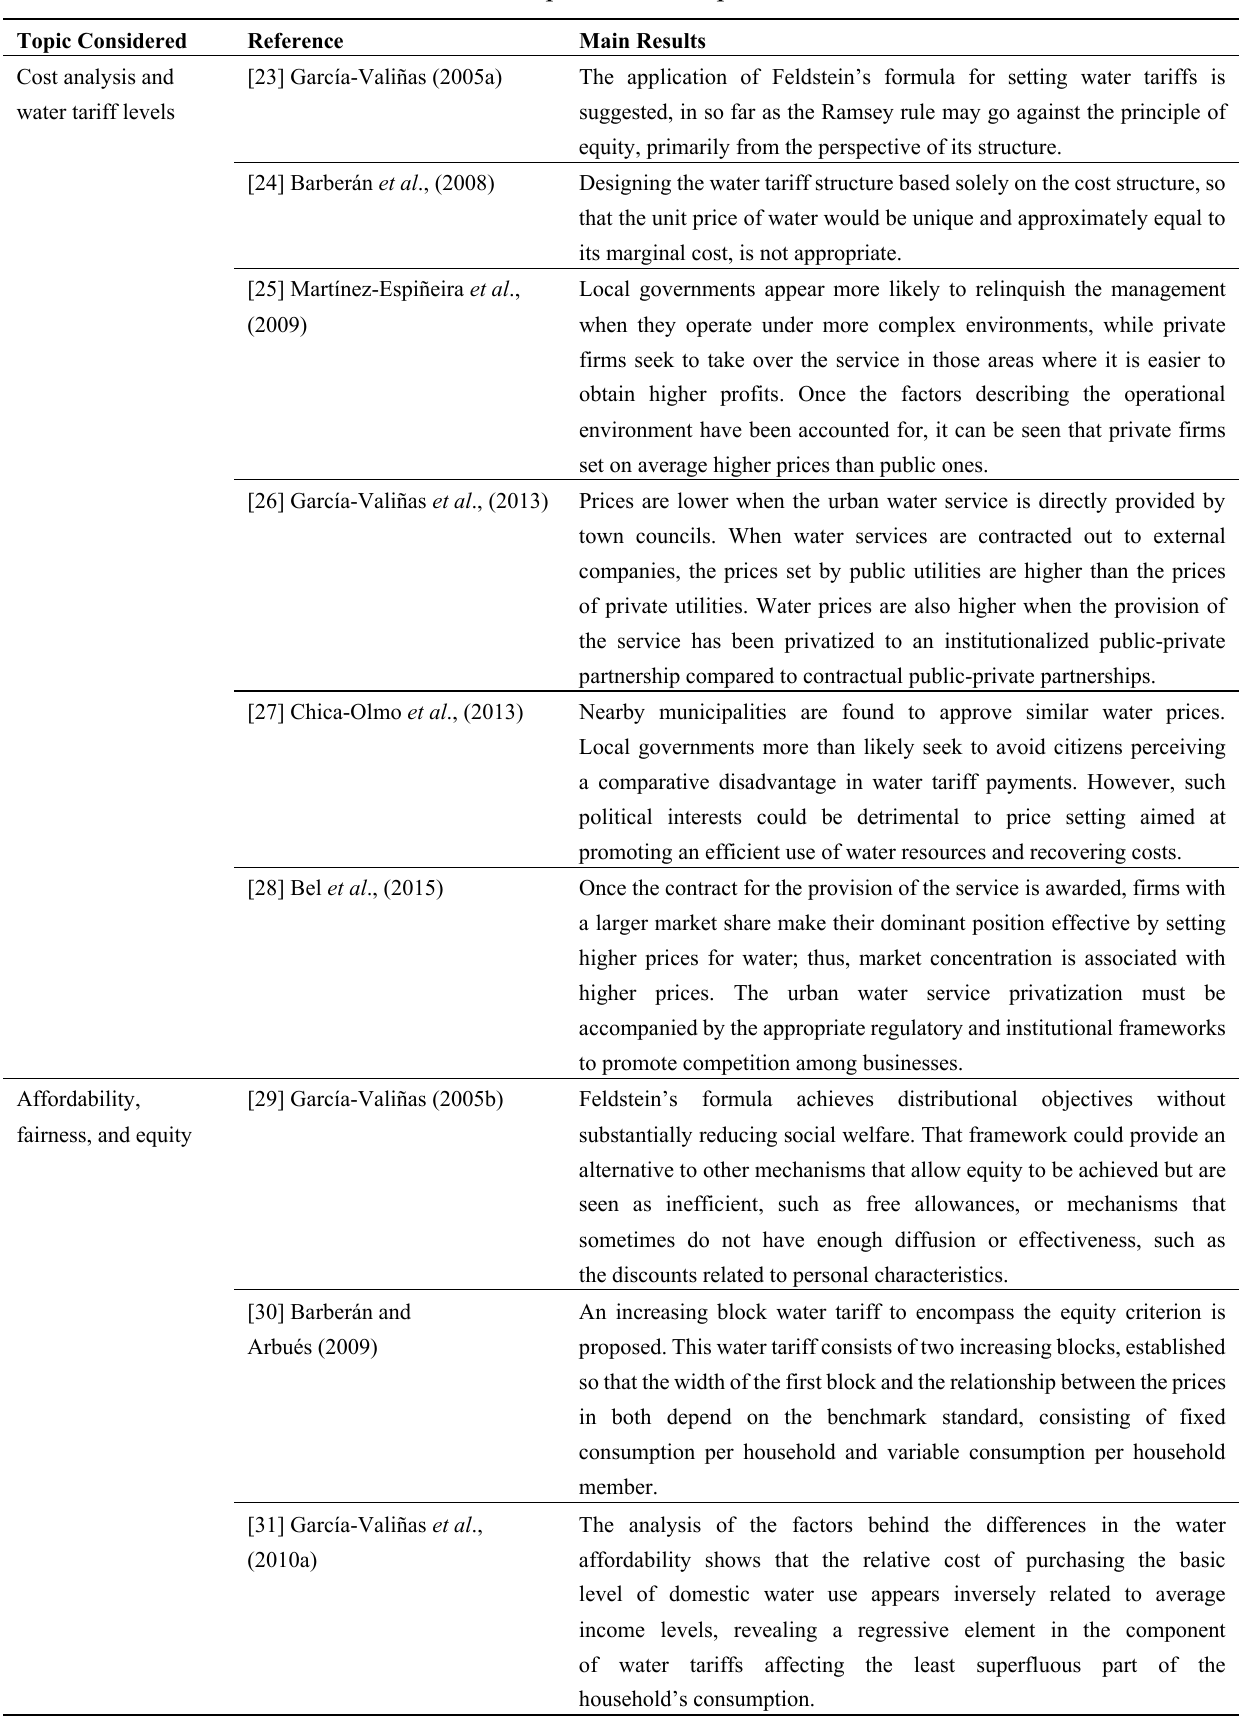
Table 1. Research in Spain on water prices in urban